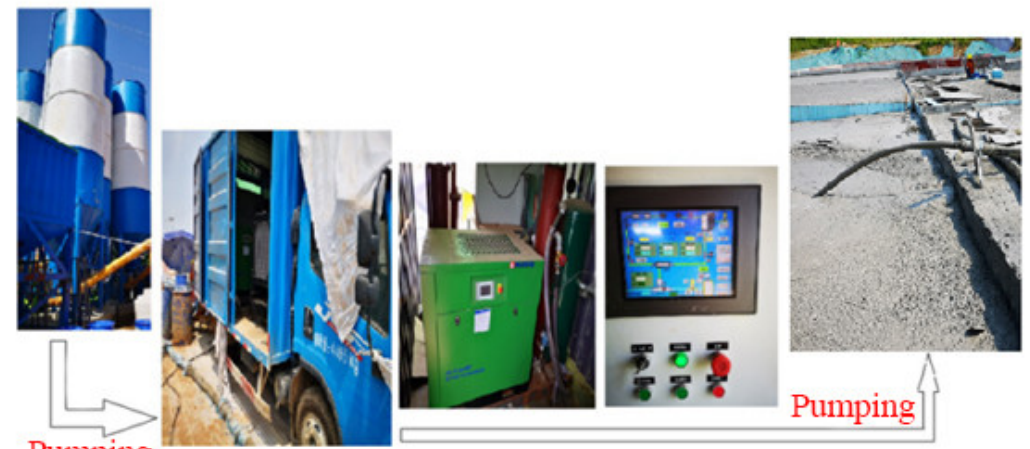
Figure 6. On-site process flow for FLS.